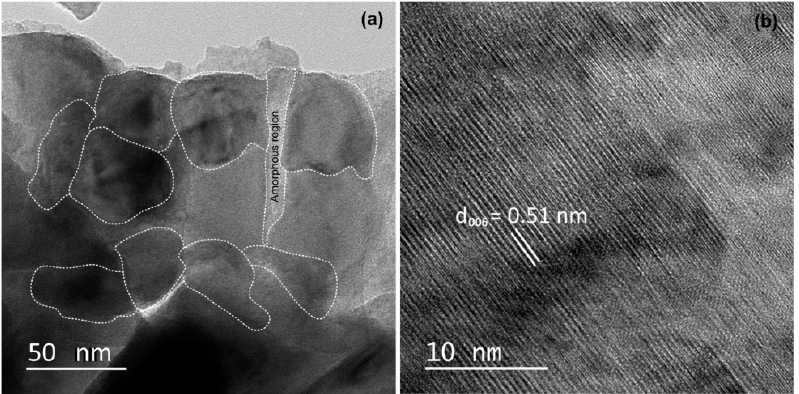
Figure 2. TEM images of the Bi 2 Te 3 film deposited at the T S of 300 °C. The dotted areas in ( a ) are used to guide the eyes of some crystallites; ( b ) the magnified HRTEM image obtained from ( a ).